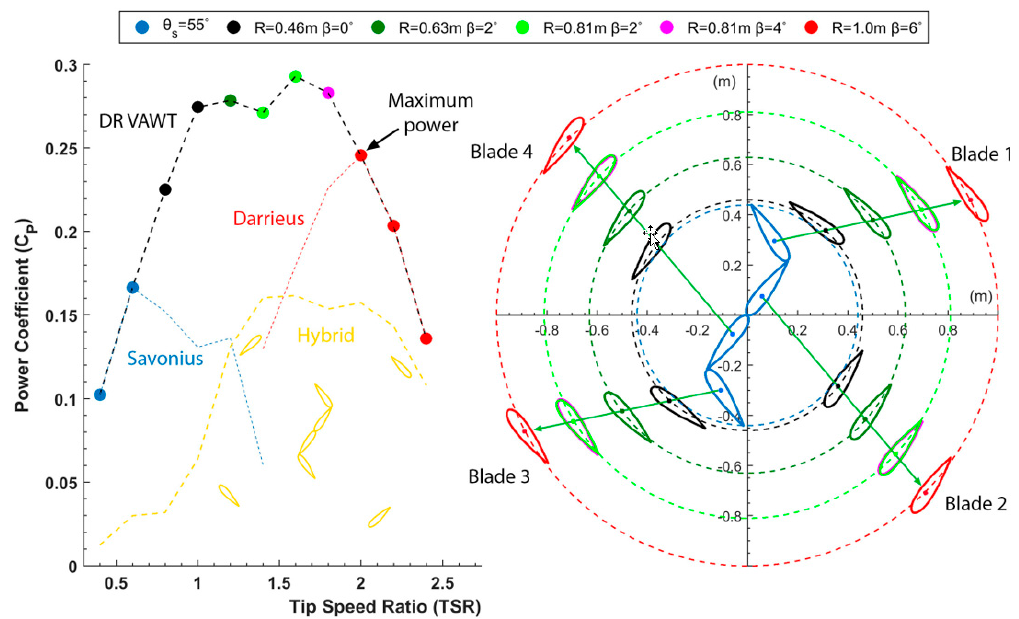
Figure 11. Overall power coe ffi cient (Cp) curve of the optimized Dynamic Rotor Vertical Axis Wind Turbine (DR VAWT) (left), and a schematic showing the optimal blades trajectories at V ∞ = 8 m / s (Re = 145,132).